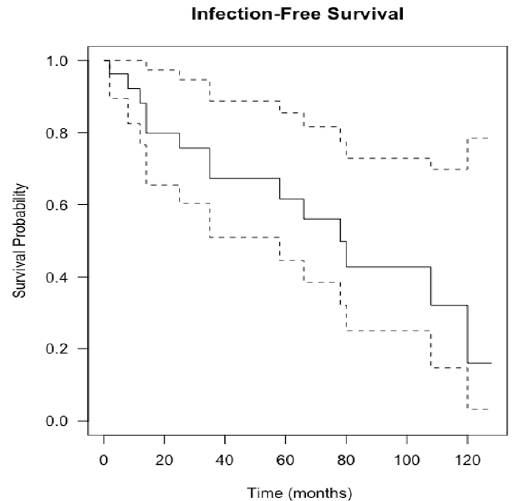
Figure 4. Kaplan–Meier curve showing infection-free survival fol- lowing knee revision surgery with gastrocnemius flap for infection eradication. The dashed lines show 95% confidence intervals.